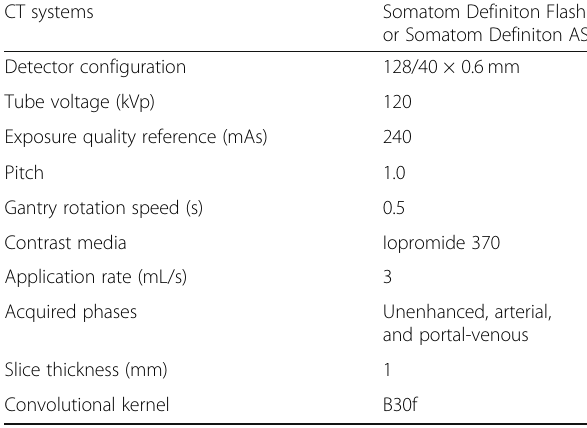
Table 2 Computed tomography scan parameters CT